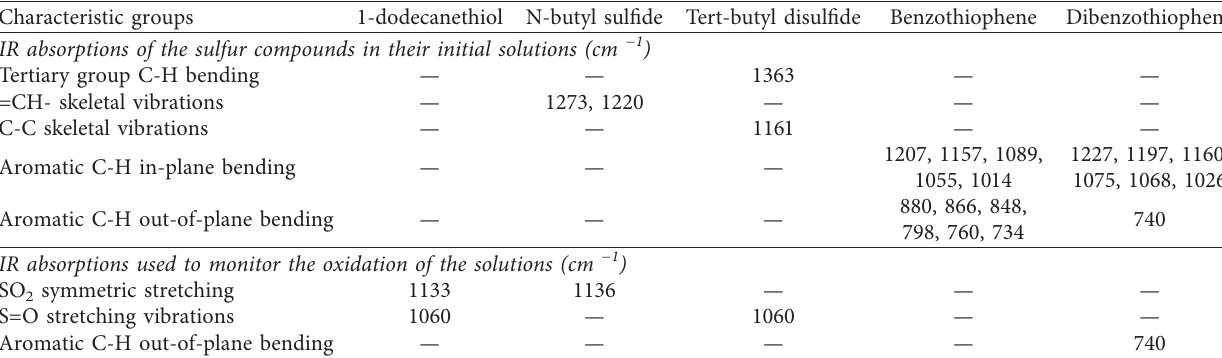
Table 3: IR absorptions of the model sulfur compounds in their initial solutions and during their oxidation. Characteristic groups that contribute to the monitoring of the oxidative process. The absorptions of the solvent, n-hexadecane, were excluded. Characteristic groups IR absorptions of the sulfur compounds in their initial solutions (cm − 1 ) Tertiary group C-H